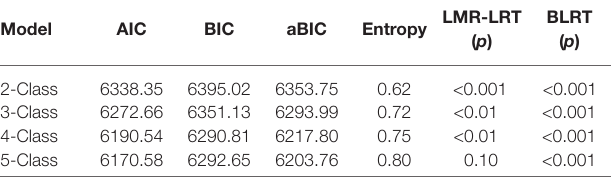
TABLE 2 | Model fit indices of the achievement goal